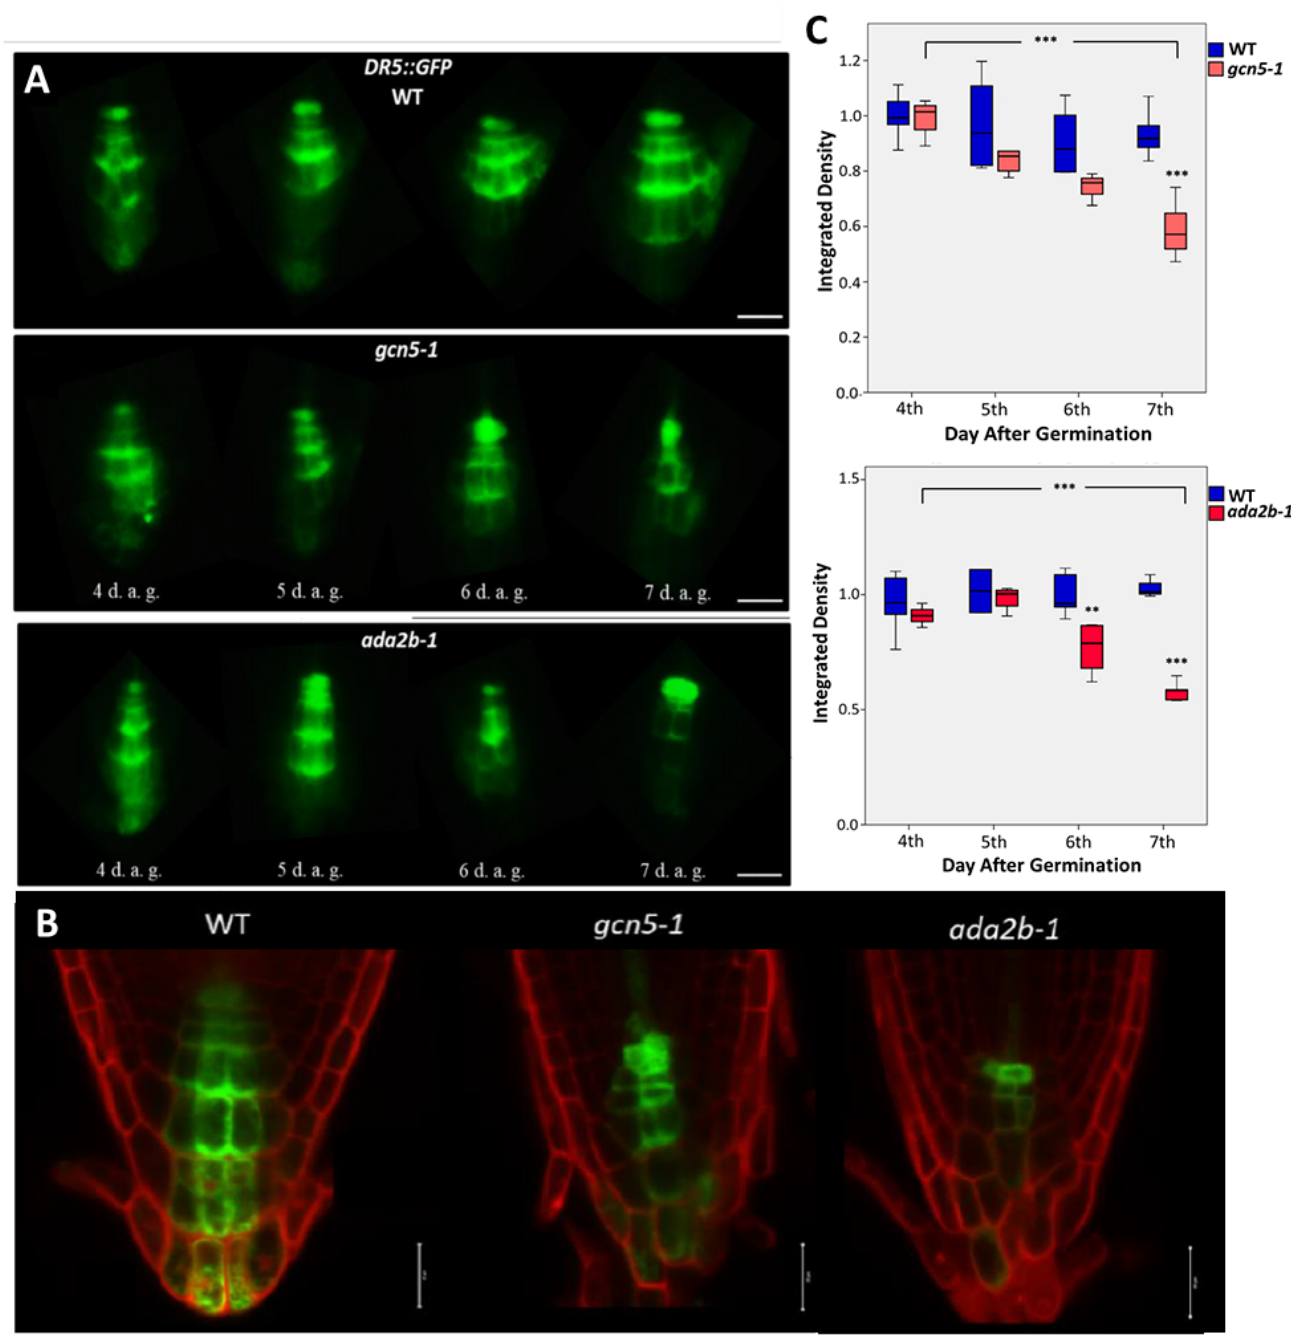
Figure 4. GCN5 and ADA2b affect auxin distribution during early root growth. ( A ) The expression of the auxin reporter DR5rev::GFP in roots of wild type, gcn5-1 and ada2b-1 mutant plants at the fourth, fifth, sixth, and seventh day after germination (d.a.g.). Scale bars represent 50 µ m. ( B ) Confocal microscopy for DR5rev::GFP expression in 7-day-old roots of WT, gcn5-1 and ada2b-1 after PI staining. Scale bars are 20 µ m. ( C ) Fluorescence density between wild-type and gcn5-1 (upper graph) and wild- type and ada2b-1 (lower graph) during root growth. The bars represent the range of the two quadrants. The horizontal line in the bar is the median, while the terminals are the minimum and maximum values of the data. Asterisks above bars of ada2b-1 indicate statistical significance compared to the same d.a.g. of wild-type. Asterisks between brackets show the difference between 4th and seventh d.a.g., using an independent samples t -test: ** p < 0.01, and *** p <